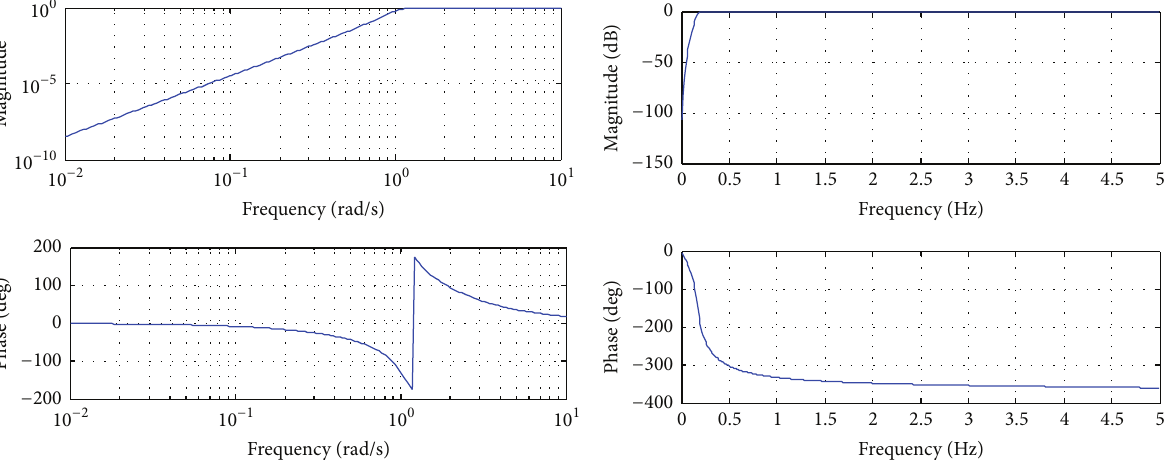
Figure 4: The corresponding analogue and digit filter.